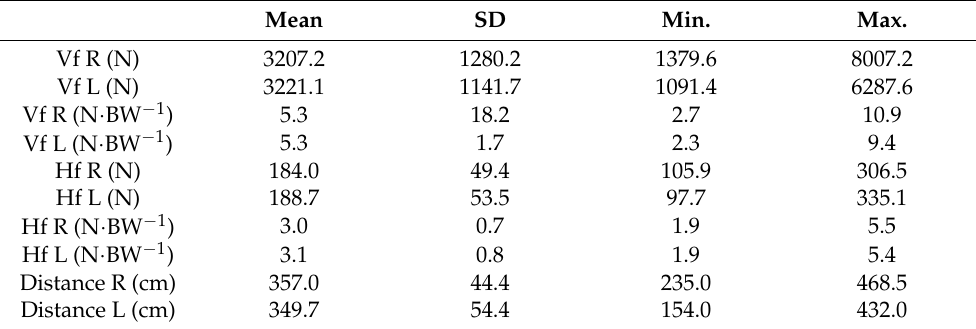
Table 4. CHOD Kinetic descriptive